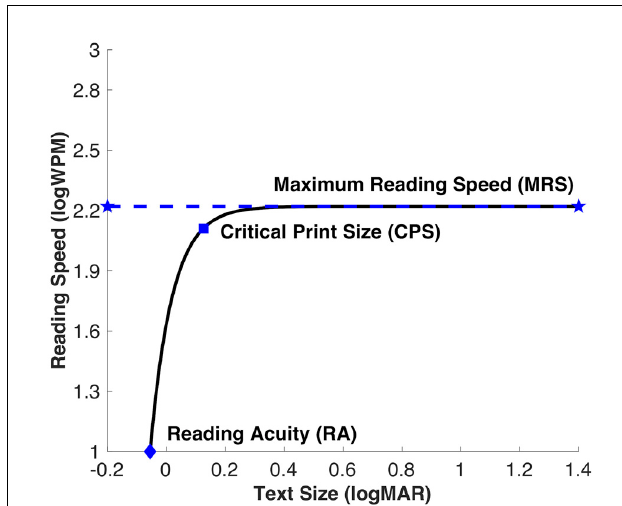
FIGURE 1 | Reading curve is defined by three parameters: asymptotic duration level corresponding to maximum reading speed, critical print size (smallest text size achieved at maximum reading speed), and reading acuity (smallest text size that can be